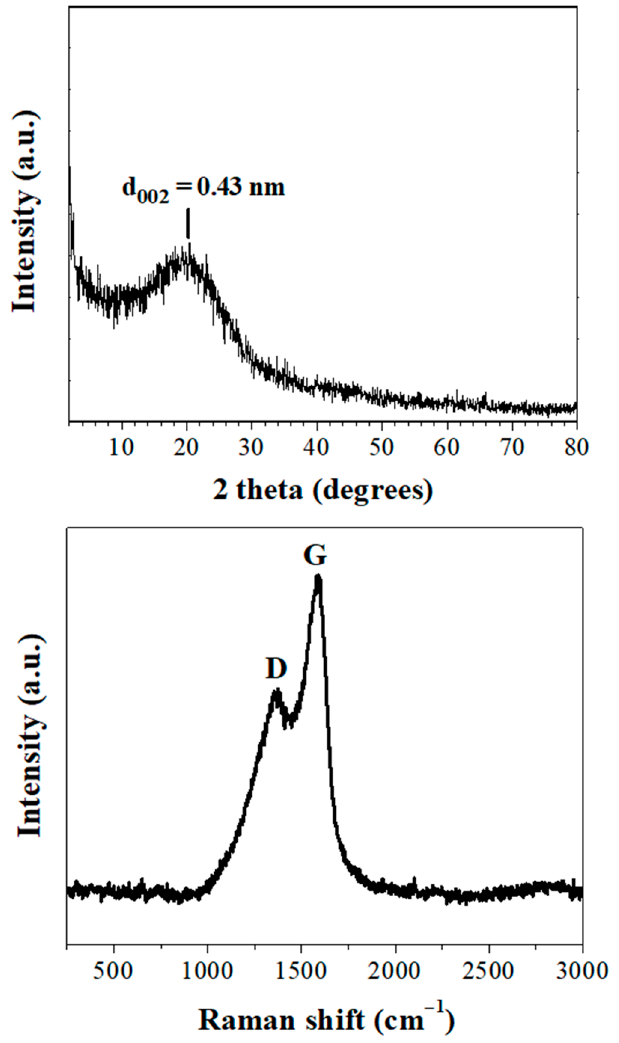
Figure 4. X-ray diffraction (XRD) pattern ( top ) and Raman spectrum ( bottom ) of carbon nanosheets.